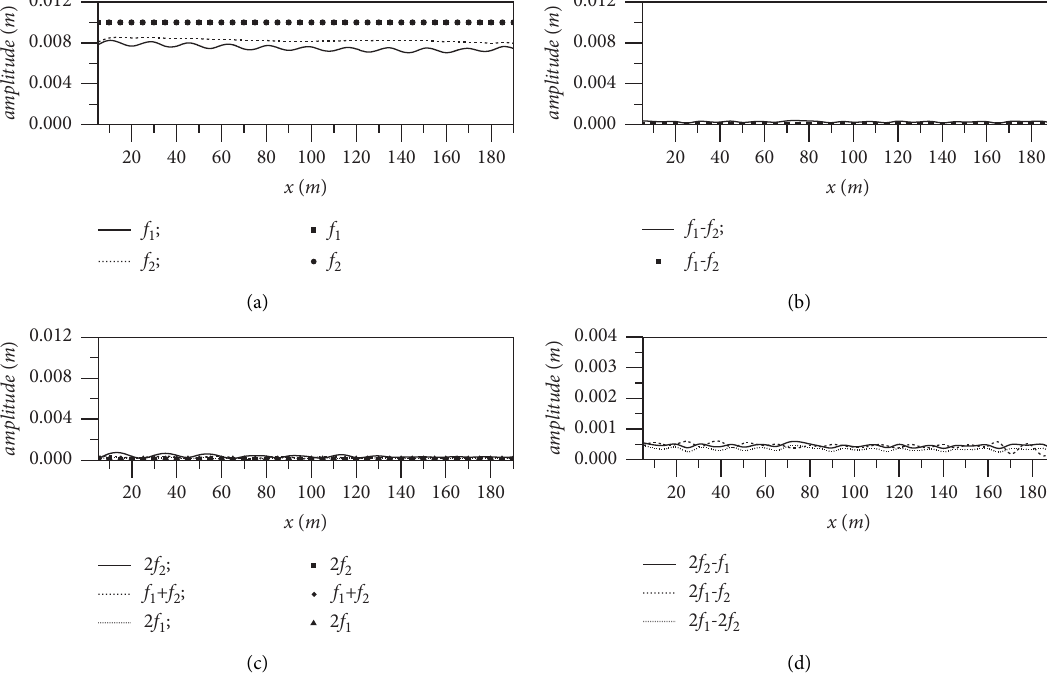
Figure 8: Comparisons of the spatial variation of amplitudes of each frequency component between calculation and theoretical results for case